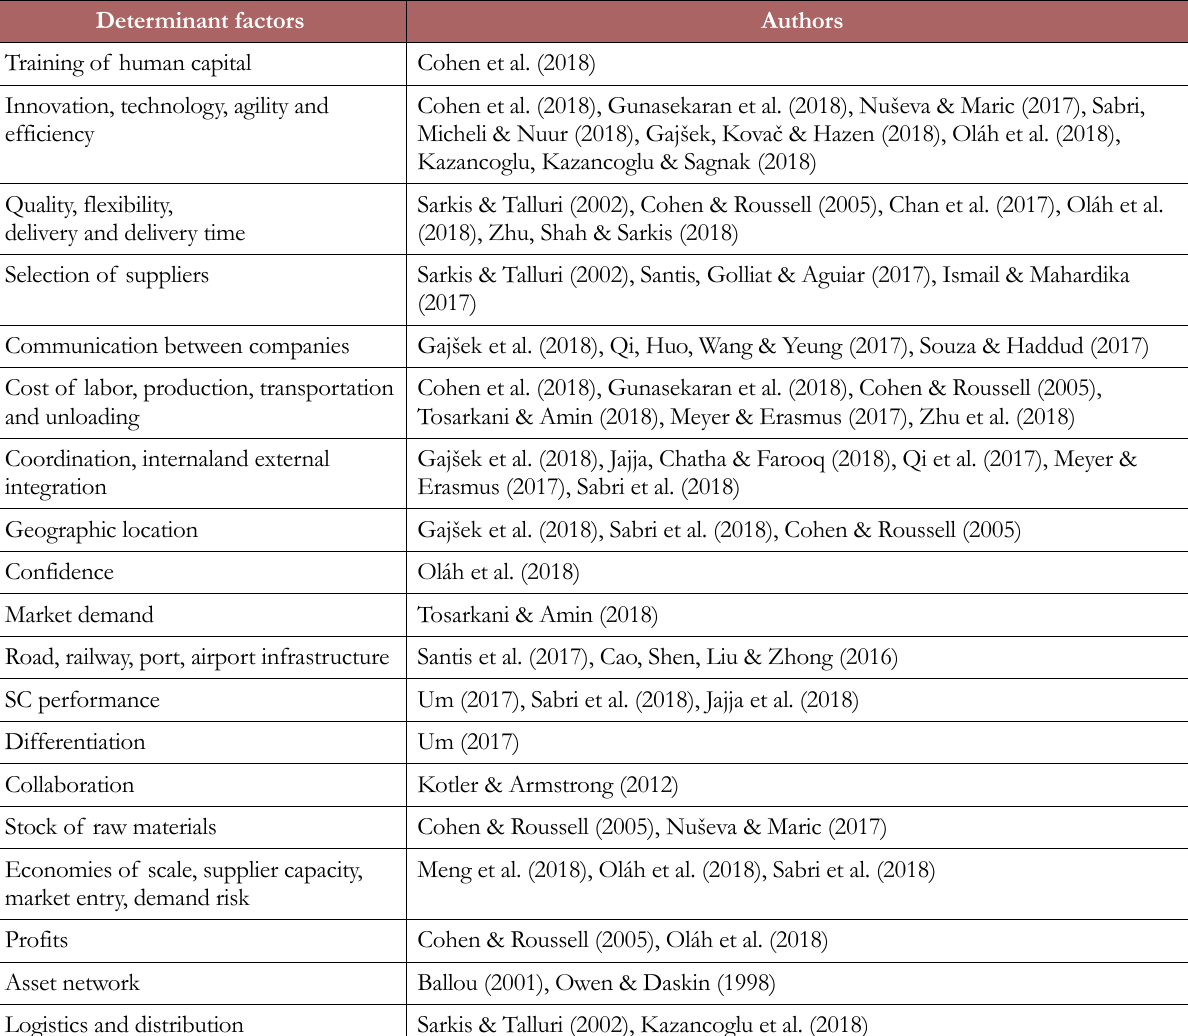
Table 1. Determinant factors in the strategic supply chain